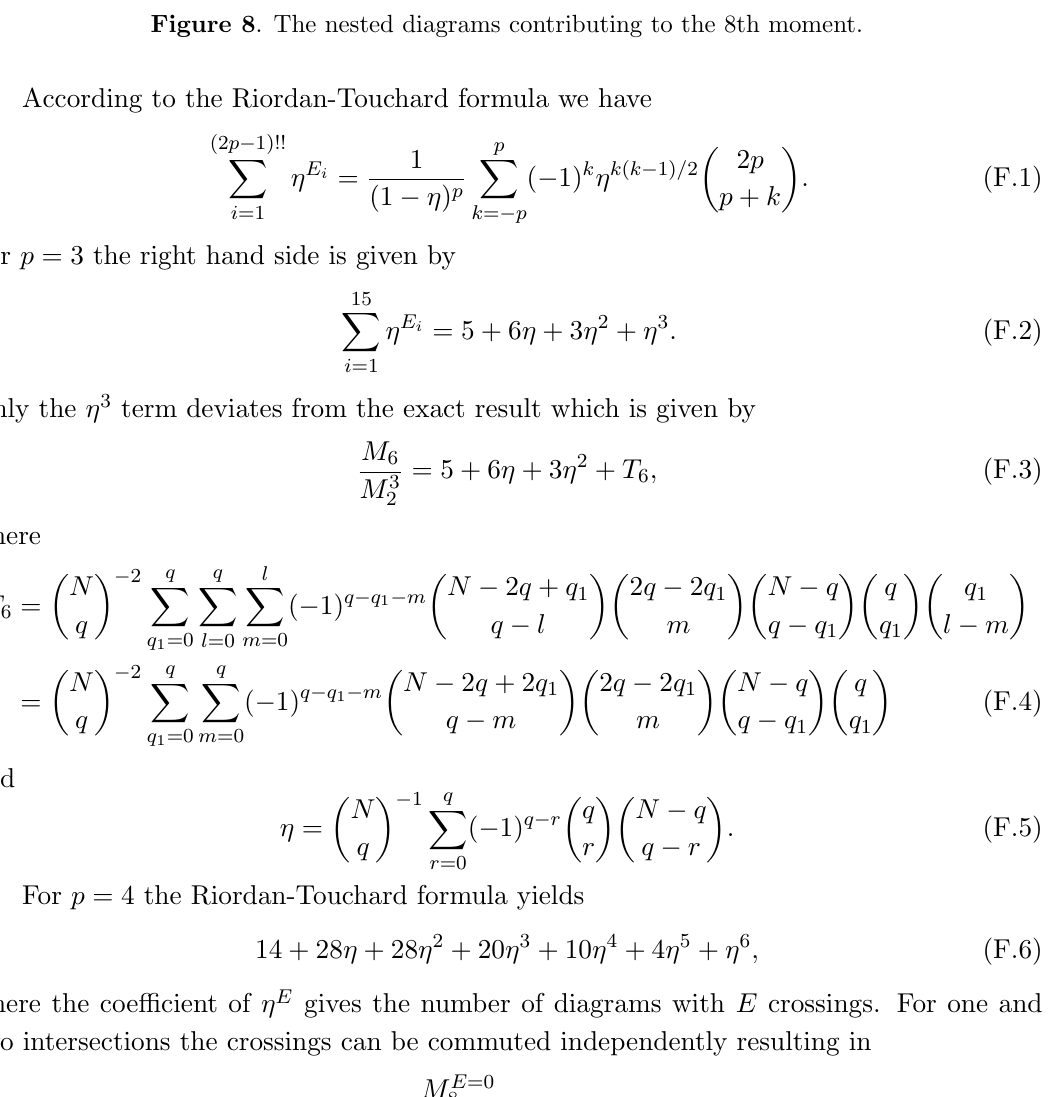
Figure 8 . The nested diagrams contributing to the 8th